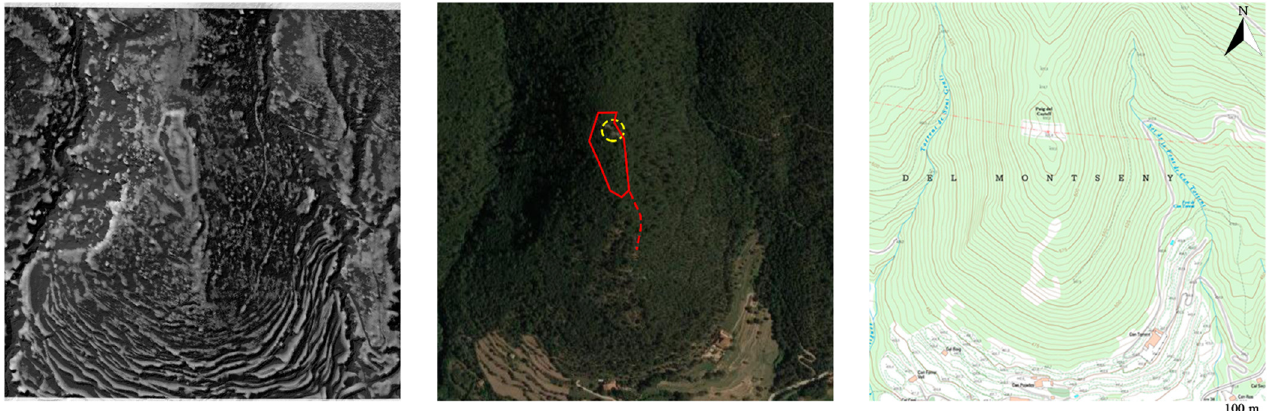
Figure 7. MSRM ( left ), satellite view ( centre ) and topographic map ( right , forest in green) of the Puig Castell site. In the satellite image the walls (red) and the known location of the settlement (yellow) are indicated.